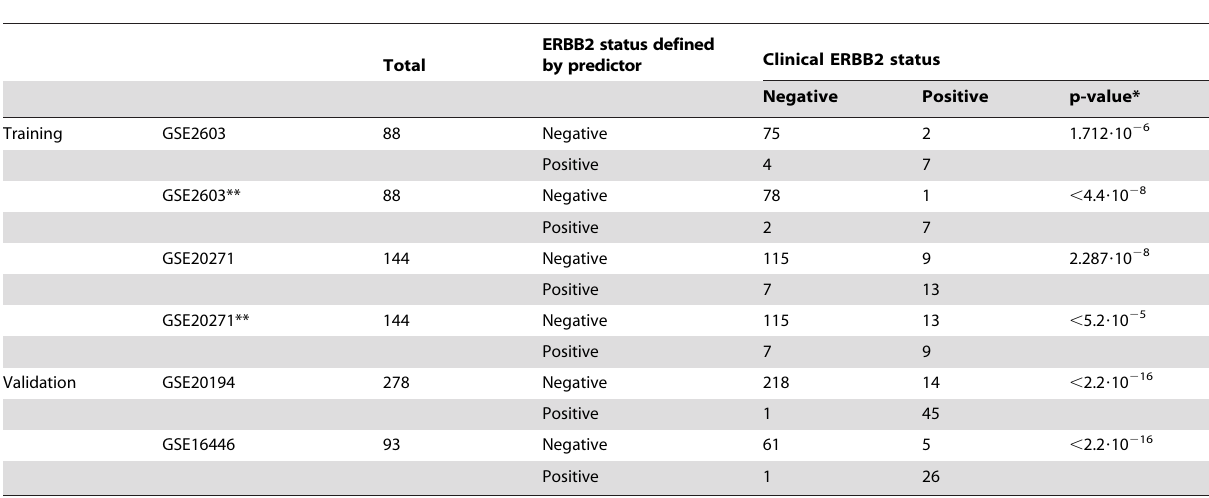
Table 4. Correlation of microarray–based expression profiling data with routinely established ERBB2 status.